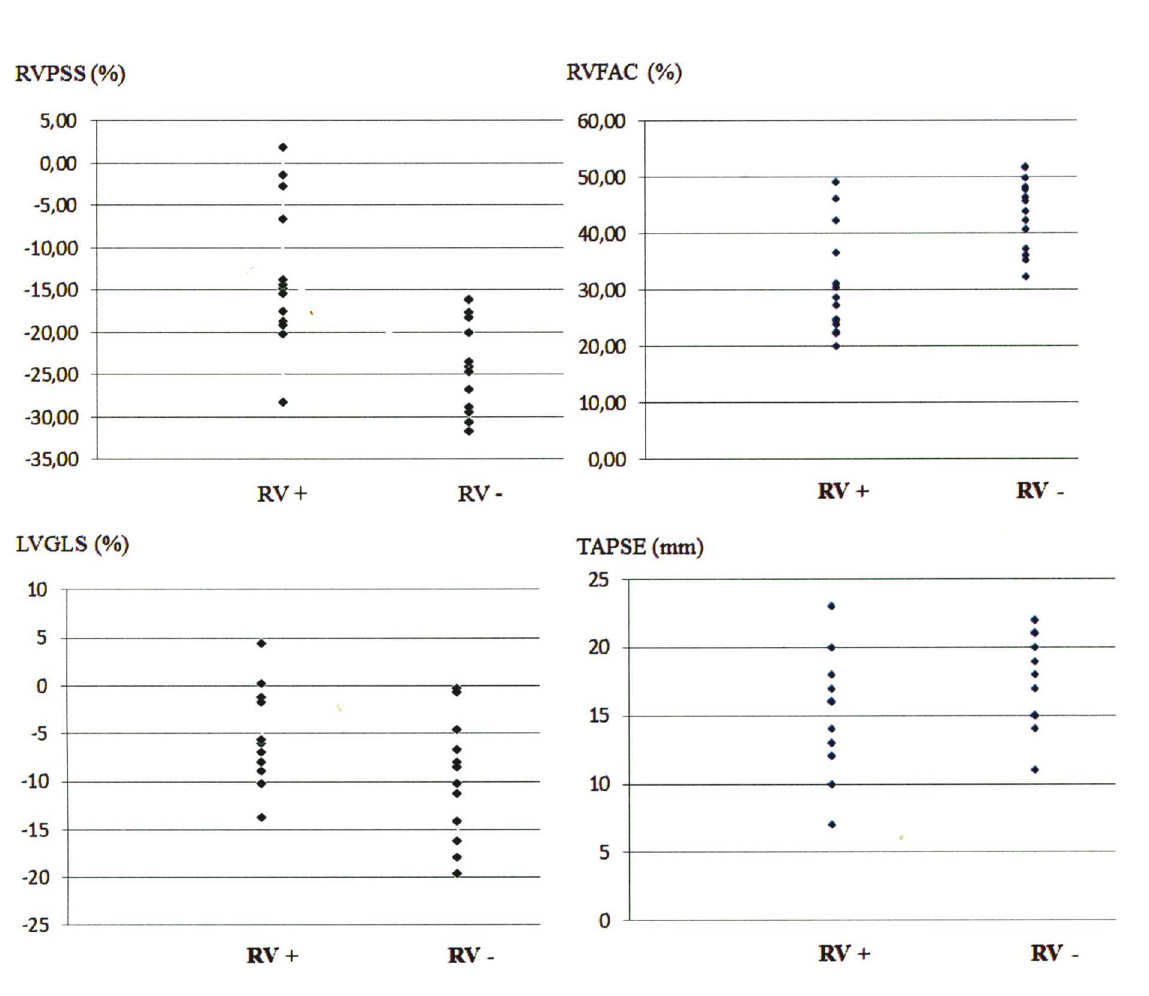
Figure 2. Distribution of RVPSS, TAPSE, RVFAC and LVGLS among patients with (RV + ) and without (RV-) right ventricular involvement displayed by dotplots. RVPSS: right ventricular peak systolic strain, TAPSE: tricuspid annular plane systolic excursion, RVFAC: right ventricular fractional area change, LVGLS: left ventricular global strain. doi:10.1371/journal.pone.0103717.g002 PLOS ONE |